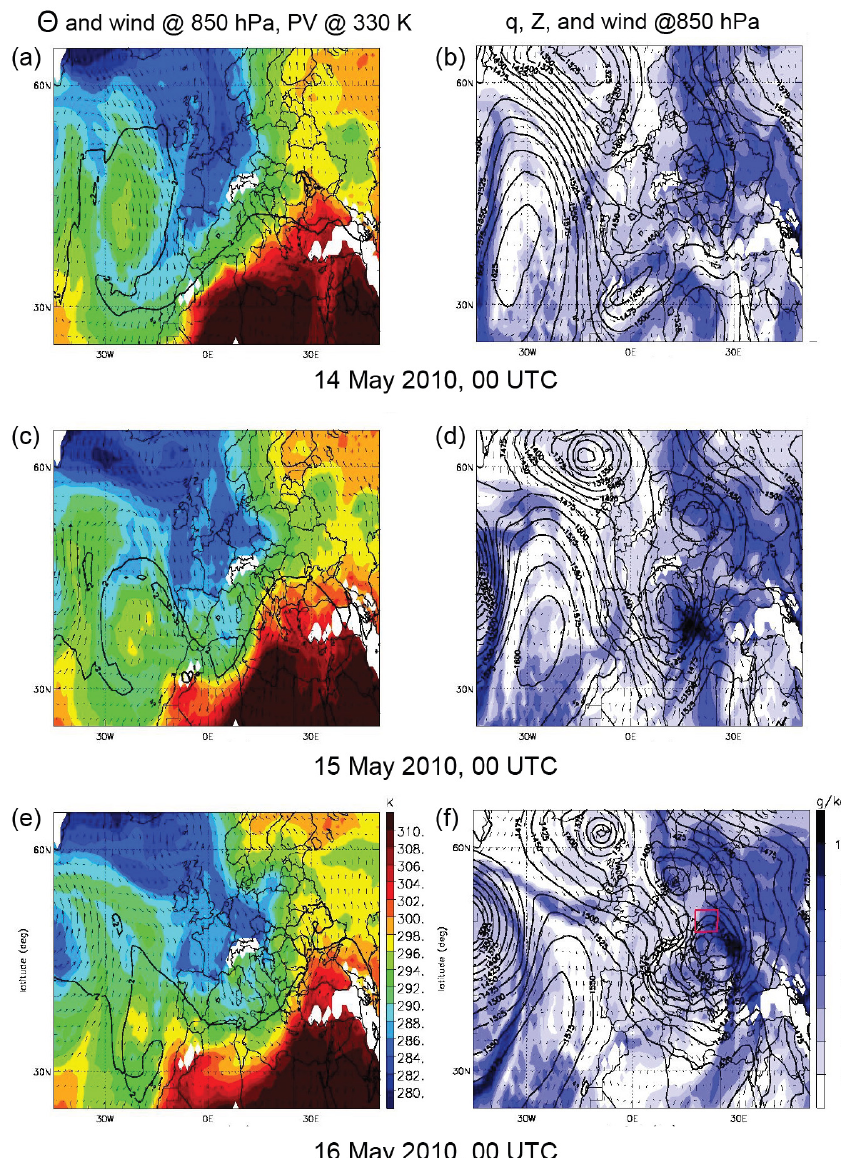
Figure 2. Left panels: ECMWF operational analysis of potential temperature (shading, in K), wind arrows at 850hPa and potential vorticity at 330K (2pvu contour) at 00:00UTC on (a) 14, (c) 15 and (e) 16 May 2010. Right panels: ECMWF operational analysis of specific humidity (shading, in gkg − 1 ), geopotential height and wind arrows at 850hPa at 00:00UTC on (b) 14, (d) 15 and (f) 16 May 2010. The red box in (f) marks the target region of the tagging experiment and the Lagrangian moisture